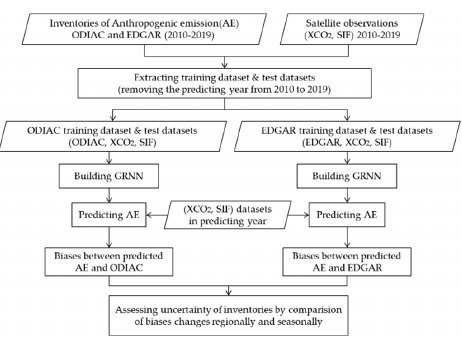
Figure A1. Workflow for training the GRNN neural network model and evaluating emission inven- tory using the predicted emissions based on GRNN trained using the satellite XCO 2 observations.